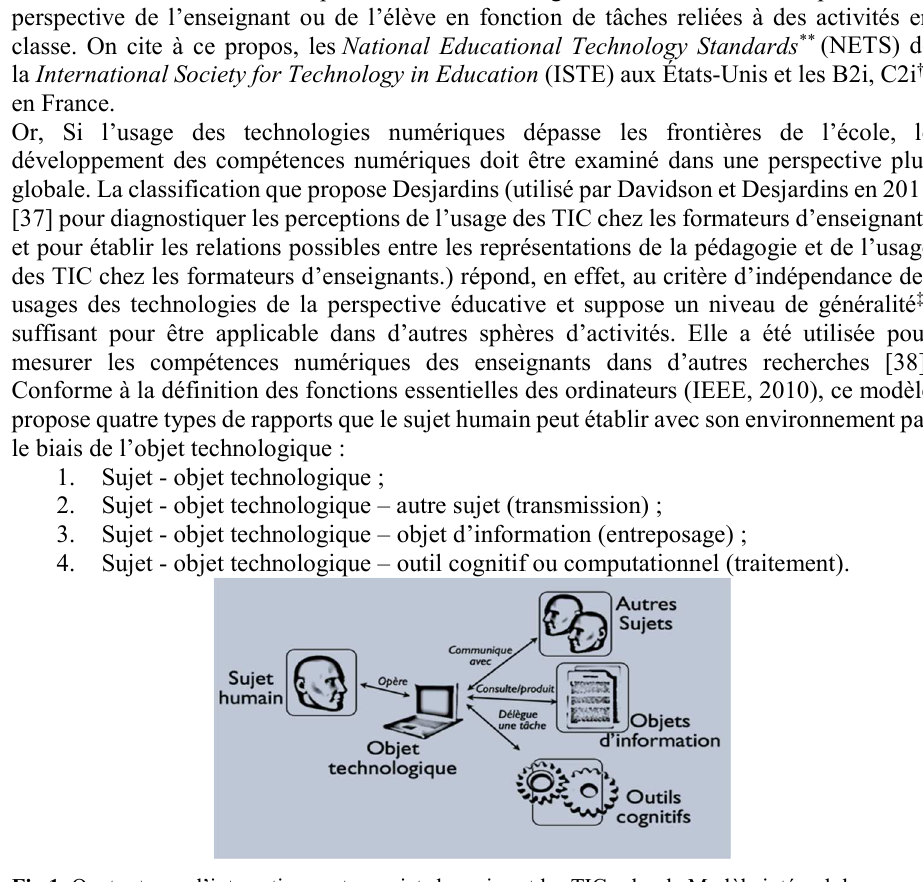
Fig.1. Quatre types d’interactions entres sujets humains et les TIC selon le Modèle intégral de Desjardins (adapté de Desjardins, 2005, p.